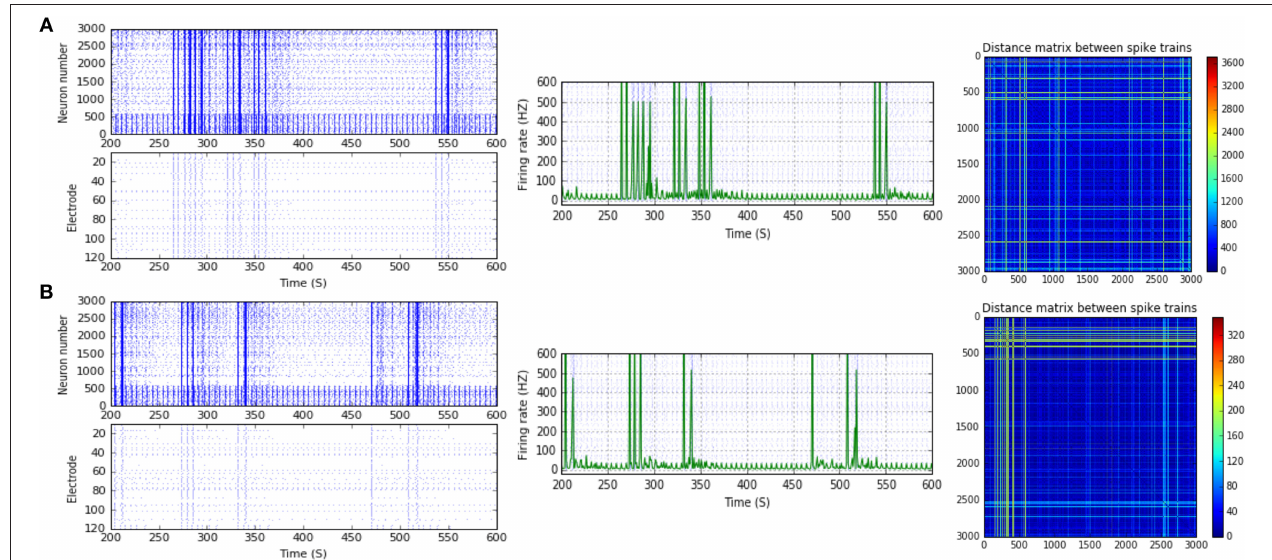
FIGURE 5 | Selected elicited firing response activity in the immature network scenario (B-2) before and after implementing STF1 (when IF alpha). (A) refers to the condition without implementing dynamical synapses (control) while (B) refers to that after implementing facilitating synapses (STF1). The first two figures of each panel refer to monitoring the pattern of firing activity in time windows from 200 to 600 seconds (s). Heat maps of each panel represent modulation changes in spike distance matrix of the network scenario (B-2) before and after implementing STF1. The simulation time for heat maps of the spike distance is equal to